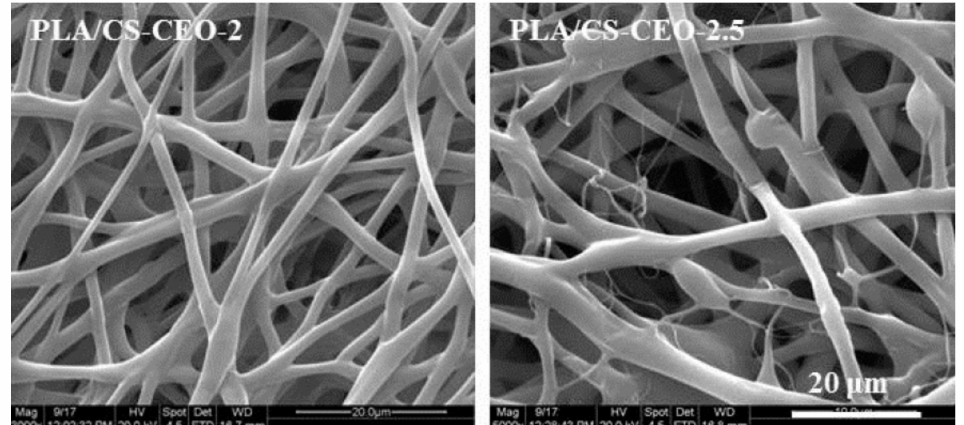
Figure 3. Poly (lactic acid) fibers containing beads of cinnamon essential oil encapsulated into chitosan nanoparticles (magnification scale 20 µ m) [194]. Reprinted with permission from ref. [194] 2017 MDPI, Basel, Switzerland,